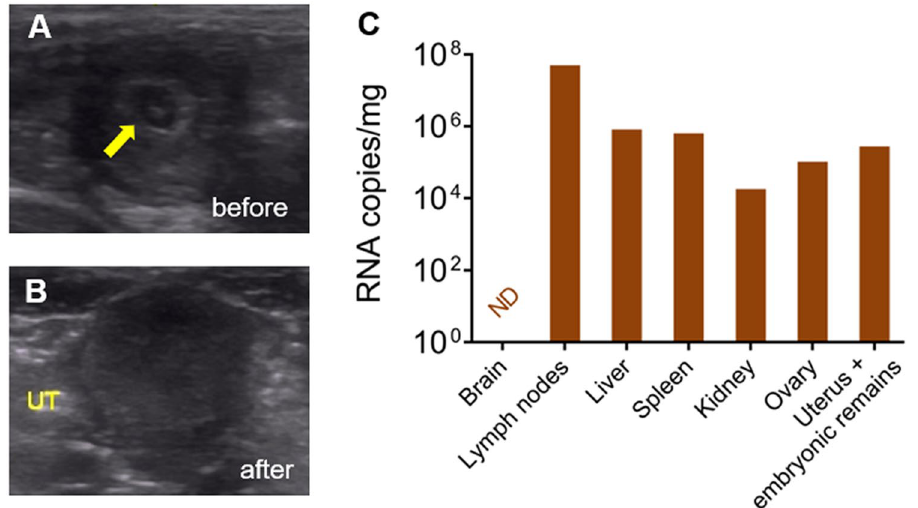
Figure 3. Experimental ZIKV infection in pregnant squirrel monkeys. Miscarriage of the squirrel monkey mother (1A) infected in the 1st GT (34 Gd). ( A ) Ultrasound image at 34 Gd, showing the uterus with a gestational sac and embryo (yellow arrow). ( B ) Ultrasound image at 41 Gd and 7 dpi, showing the uterus with no gestational structures (UT: uterus). ( C ) Detection of viral RNA in tissues from the miscarriage. (ND: Not